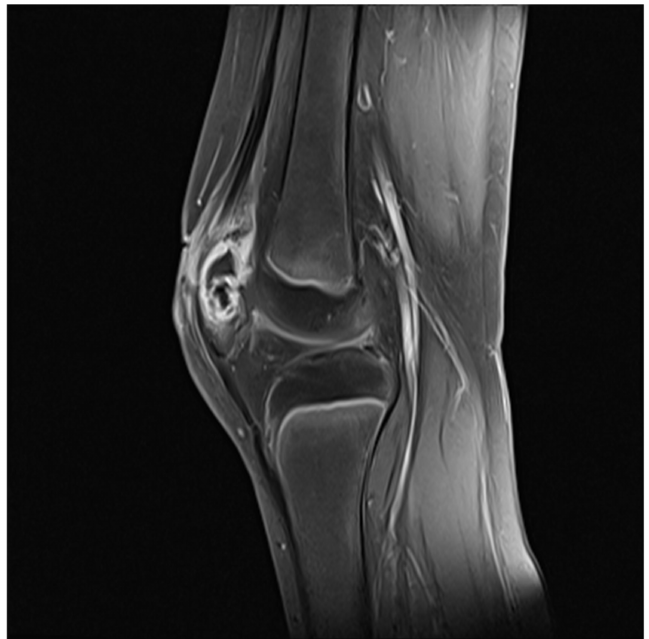
Figure 6. Preoperative gadolinium-enhanced MRI indicated heterogeneous enhancement of the patella with a fistula between the patella medullary canal and subcutaneous fat in the left patellar area. Following diagnosis of chronic osteomyelitis and abscess in the left patella, open lavage and debridement of abscess and sequestrum at the patella were planned by an anterior approach without arthrotomy. Intraoperatively, active pus and hypertrophied synovium were noted upon skin incision, and swab culture was performed. Necrotic bone debris and sequestrum at the patella were thoroughly curetted and debrided with massive irrigation through medial and lateral bone defects on the anterior cortex of the patella along with tissue culture and bone biopsy (Figure 7). The intraoperative histologic examination confirmed chronic osteomyelitis, but no microorganism was cultured on both swab and tissue specimens. Postoperatively, the patient was treated with intravenous cefotaxime for four weeks and discharged without further use of oral antibiotics upon consultation with the pediatric infectious disease specialist.